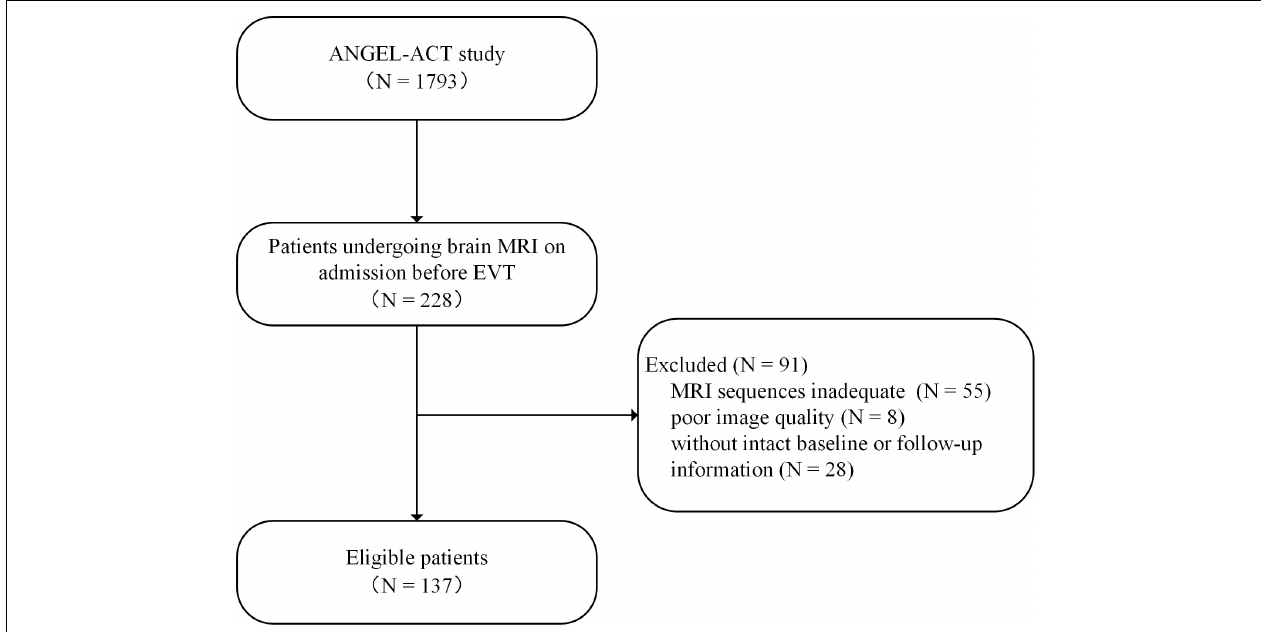
FIGURE 1 | Flowchart of patient